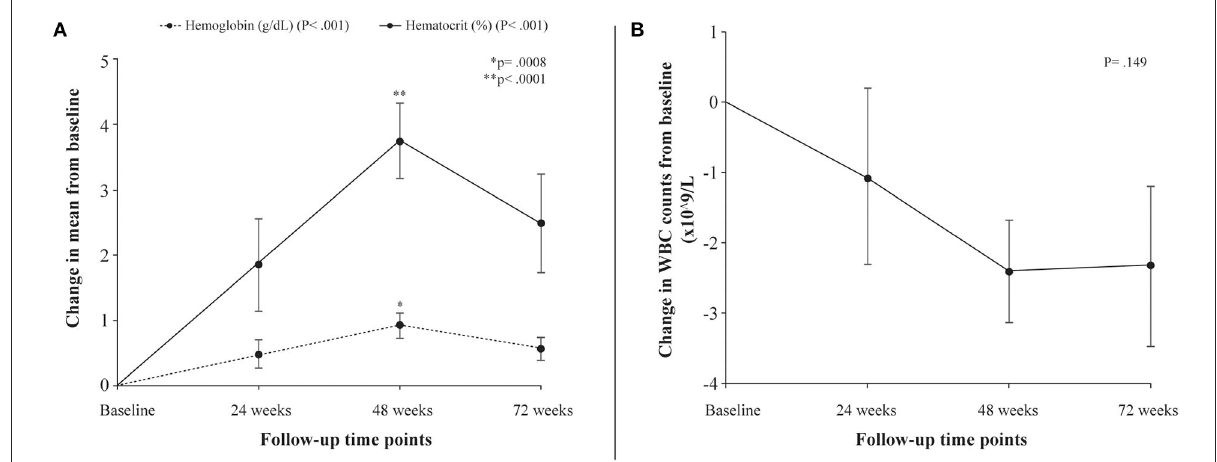
FIGURE1 Differences in laboratory parameters from baseline to follow-up time points. (A) Change in mean levels of hemoglobin (g/dL) and hematocrit (%) from baseline to follow-up time points. (B) Change in mean WBC counts from baseline to follow-up time points. P denotes probability values for repeated measures ANOVA; p denotes probability value of pairwise comparison of mean difference (Bonferroni correction) in hemoglobin levels ( * ) and hematocrit ( ** ) at 48 weeks from baseline.